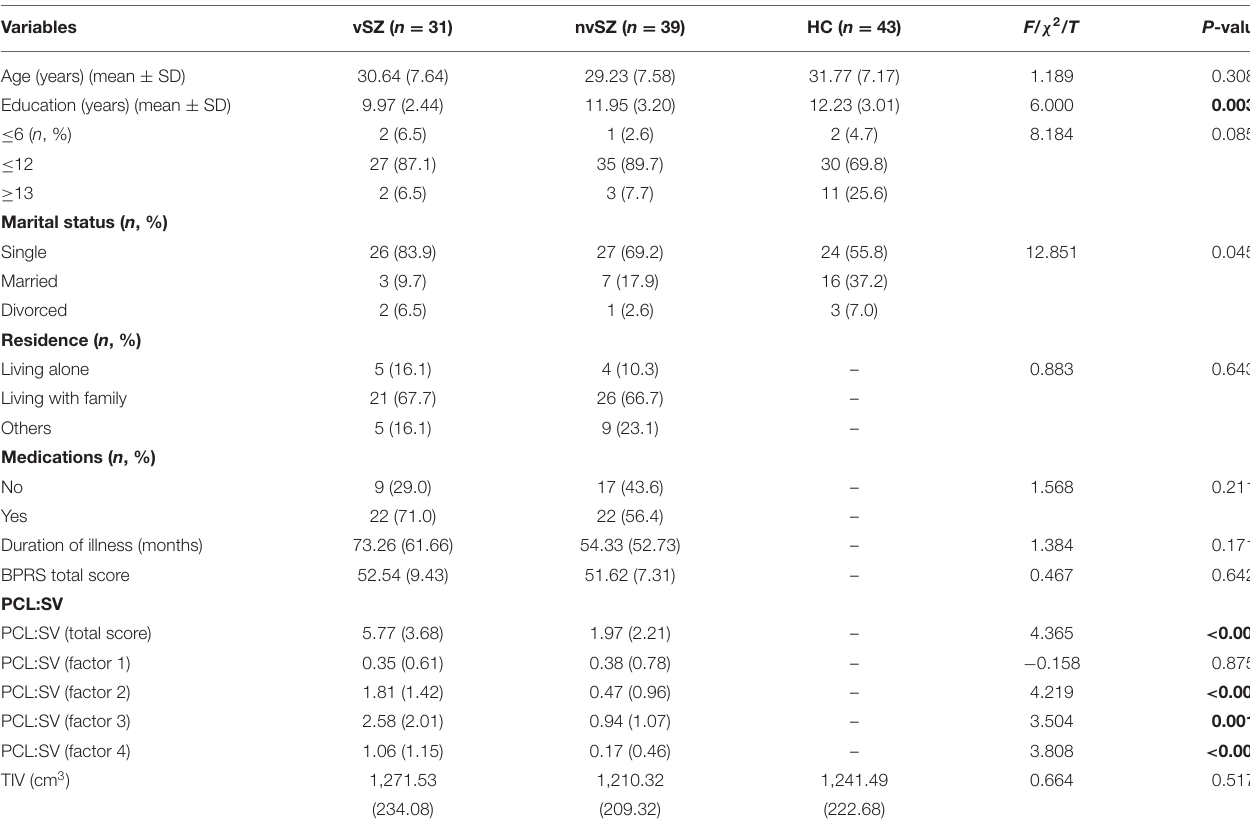
TABLE 1 | Characteristics of demographic and clinical data of all groups.